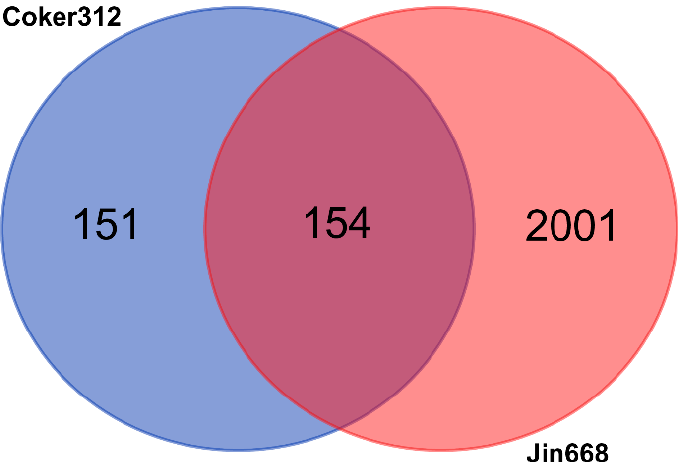
Figure 2. A Venn diagram representing gene expressions that are common and unique in Coker312 and Jin668 at the NEC and EC stages.